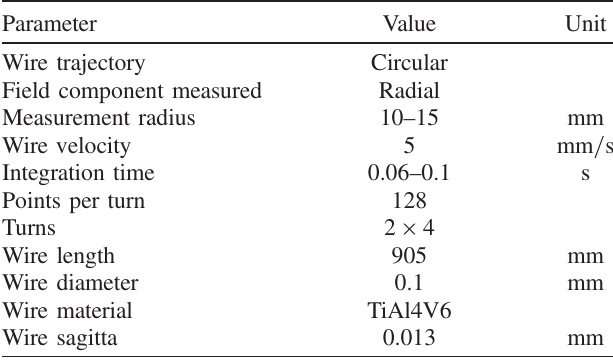
TABLE V. Measurement parameters. The bench control and analysis software is available online [16]. The wire is moved by two sets of Newport ILS100-CC and IMS100V stages driven by a Newport XPS motion controller. The induced voltage was measured with a Keithley 2182A voltmeter.